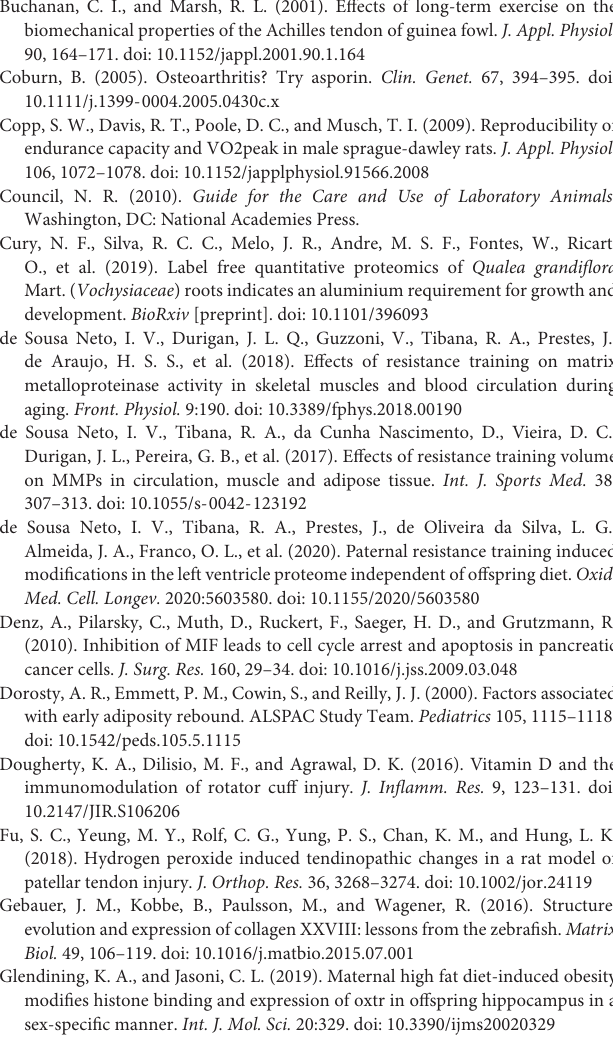
FIGURE S1 | Classification of the identified proteins according to the GO terms: cellular localization (A) , biologic process (B) , and molecular function (C) . FIGURE S2 | Venn diagram representation of the identified proteins by Nano LC-MS analysis in the fathers (A) and offspring groups (B) , showing high consistency of protein identification among the groups. Proteins identified in non-overlapping groups were classified by their biological